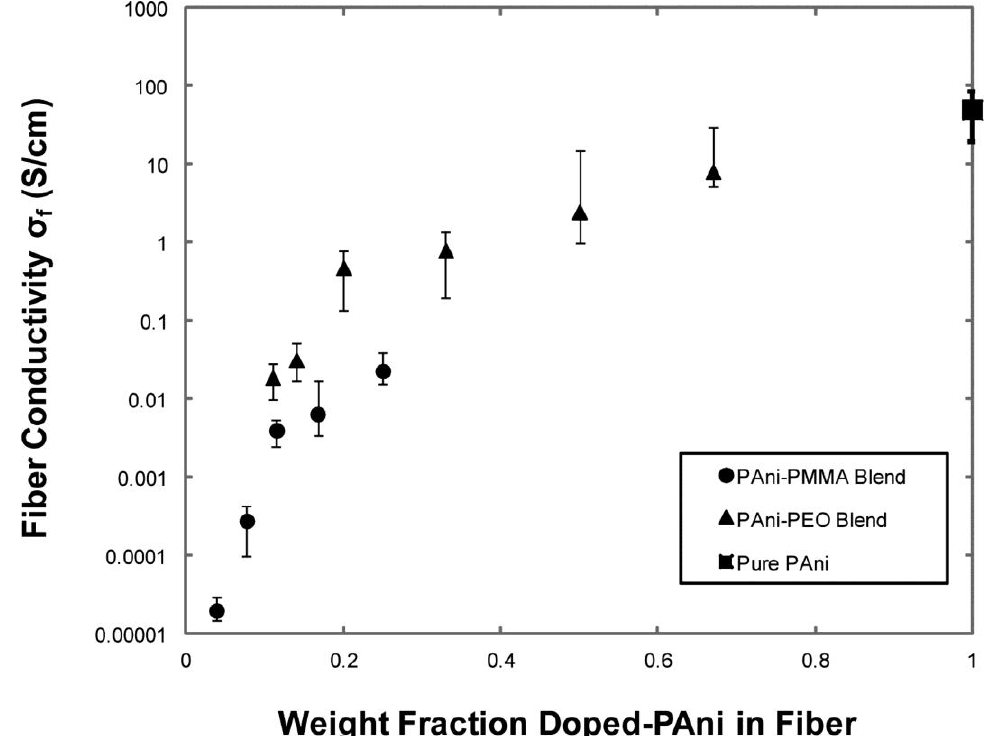
Figure 5. Electrical conductivity of as-electrospun polyaniline (PANI) fibers (nominally doped with an equimolar amount of D,L-camphorsulfonic acid, HCSA) as a function of the weight fraction of PANI in the blended fibers; the pure PANI fiber was obtained after dissolving the shell component (PMMA) of the core−shell fibers. Reprinted with permission from [102]. Copyright (2012) by American Chemical